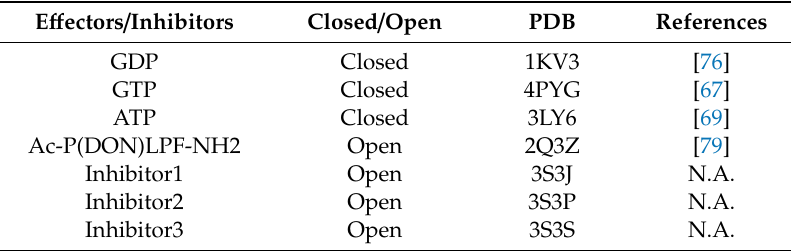
Table 1. Structures of TGase2 complexed with e ff ectors and inhibitors. E ff ectors / Inhibitors Closed / Open PDB GDP Closed 1KV3 GTP